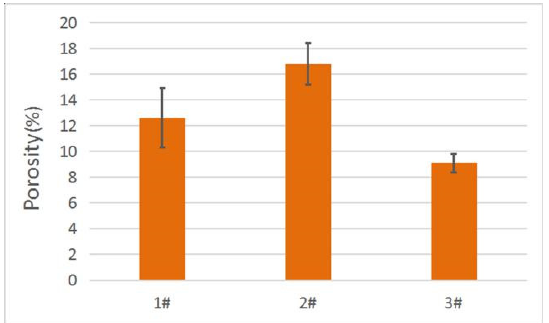
Figure 9. Porosity inside the columns of LC coatings.